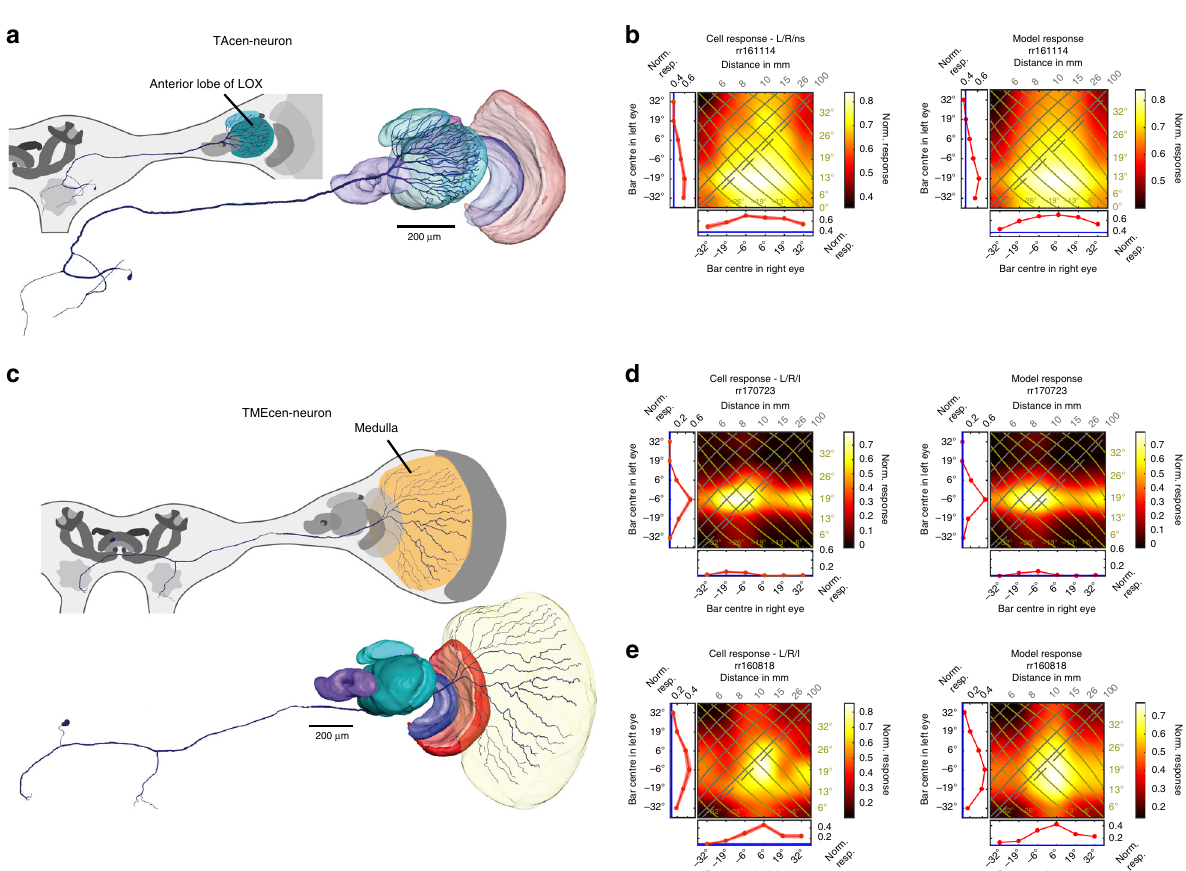
Fig. 4 Centrifugal (feedback) neurons. a Anterior view of reconstructed TAcen-neuron (tangential centrifugal neuron of the anterior lobe) with rami fi cations in anterior lobe of LOX and central brain. b Cell (left) and model (right) response fi elds for an example TAcen-neuron to fl ashed, bright bars (responses of 5 further TAcen-neurons in Supplementary Figs. 6, 7). c Anterior view of reconstructed TMEcen-neuron (tangential centrifugal neuron of the medulla) with rami fi cations in medulla and central brain. Scale bar 200 µ m. d , e Cell and model responses for two TMEcen-neurons to fl ashed dark bars. Four further TMEcen-neuron response fi elds in Supplementary Figs. 8c – f. Response fi eld header with outcome of two-way-ANOVA with “ L ” ( “ R ” ) being signi fi cant left (right) eye input and “ I ” signi fi cant interaction term (see Table 1), otherwise “ ns ” meaning not signi fi